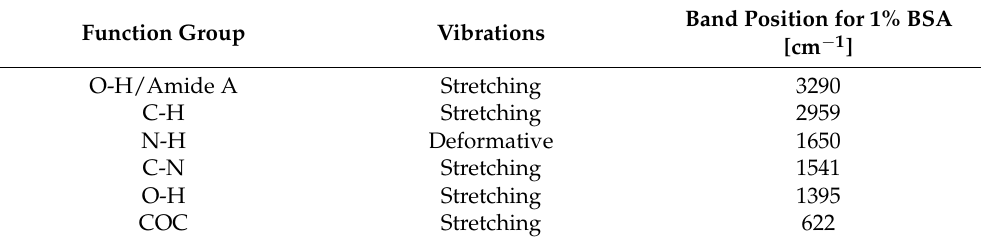
Table 2. The positions of bands in IR spectra (wavenumbers) for bovine serum albumin.